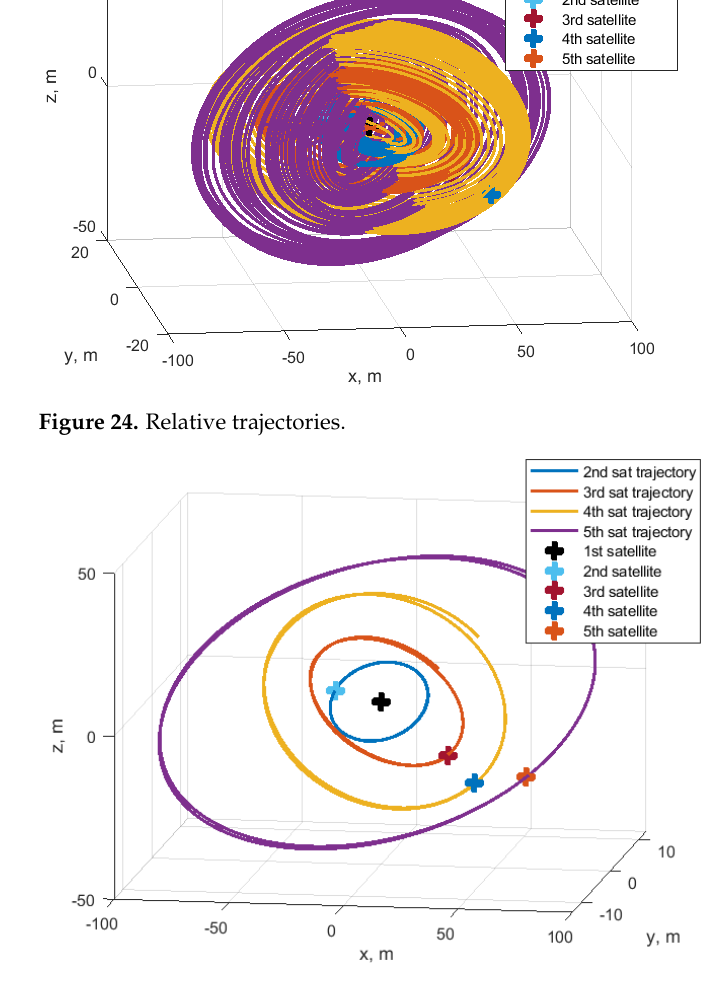
Figure 27. Relative shift. Figure 28. In-plane amplitude.